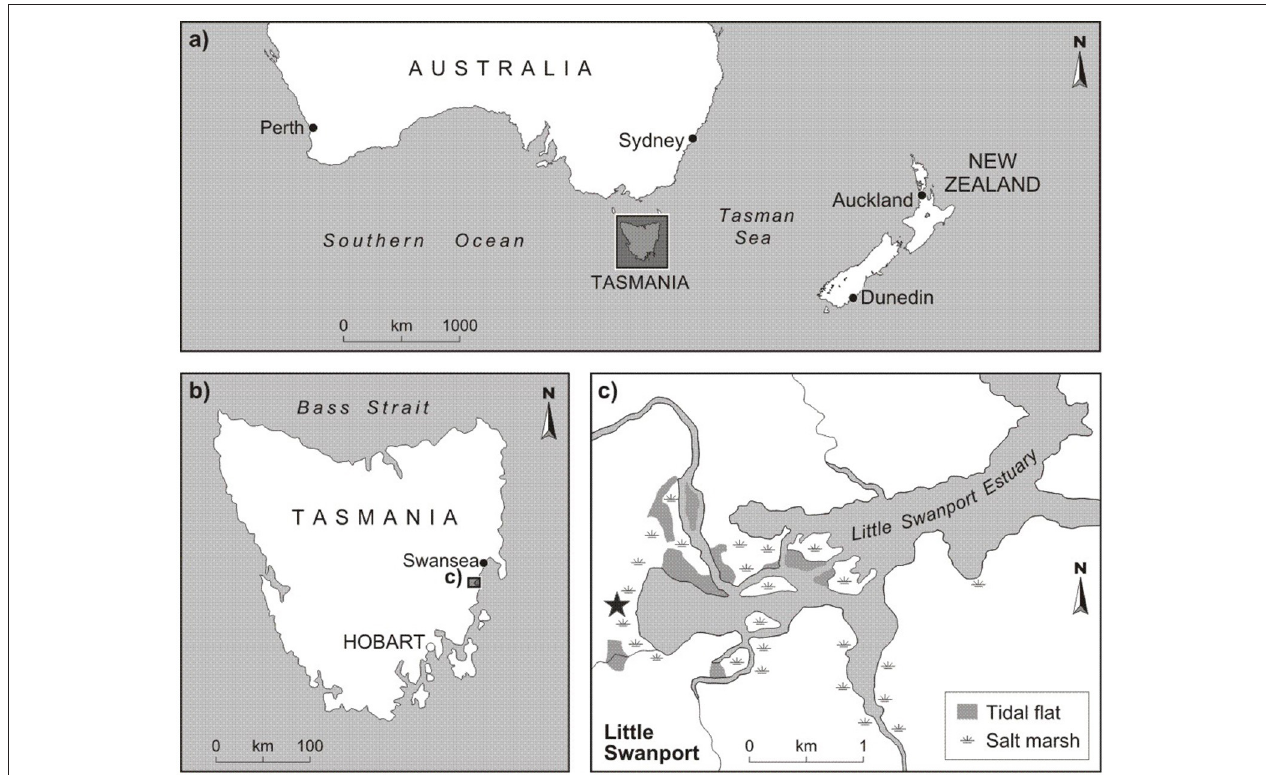
FIGURE 1 | Location of Tasmania (A), Little Swanport Estuary (B), and the core location (C), which is marked by the